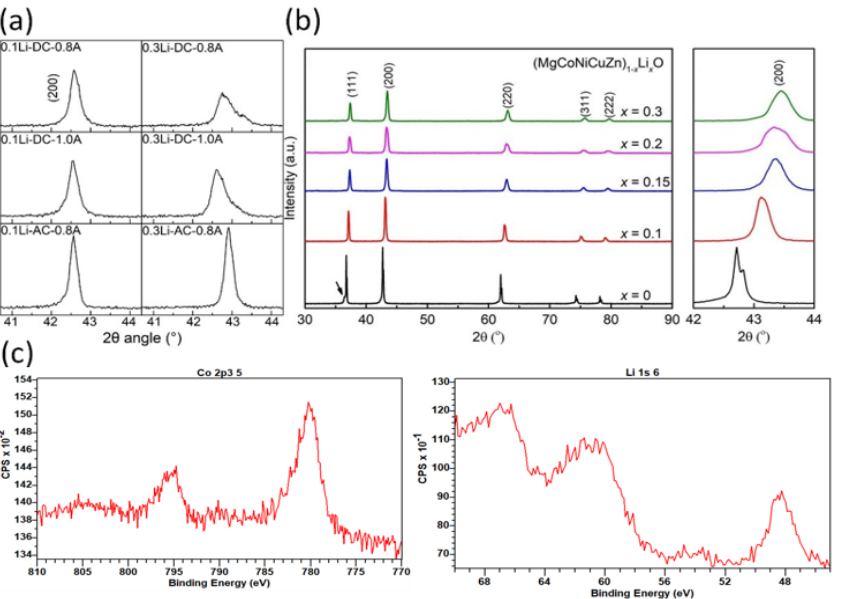
Figure 6. ( a ) The (200) peaks of samples sintered under different conditions in this study; ( b ) magni- fied view of the (200) peak showing the high-angle shift upon Li incorporation, flash-sintered under 735 mA/mm 2 for 60 s, reproduced with the permission of ref. [26], copyright @2022, Journal of Ameri- can Ceramics; ( c ) X-ray photoelectron spectroscopy (XPS) spectra of 0.1Li-DC-1.0A sintered